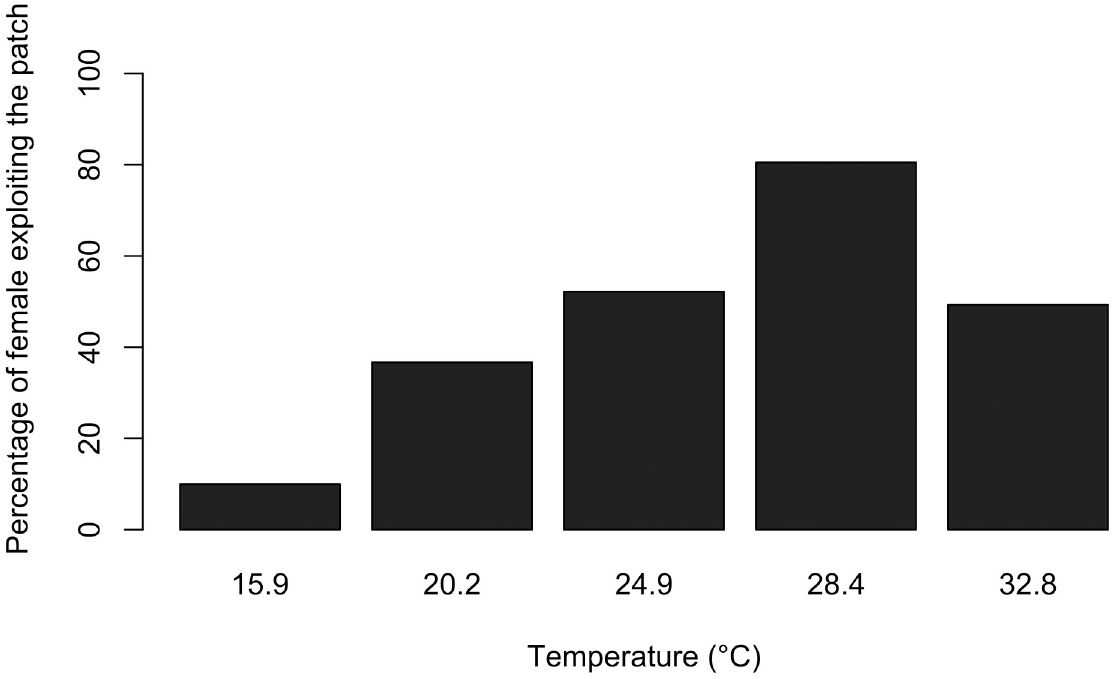
Fig 1. Percentage of females Anaphes listronoti that oviposited in at least one host egg ( Listronotus oregonensis ) at different temperatures.